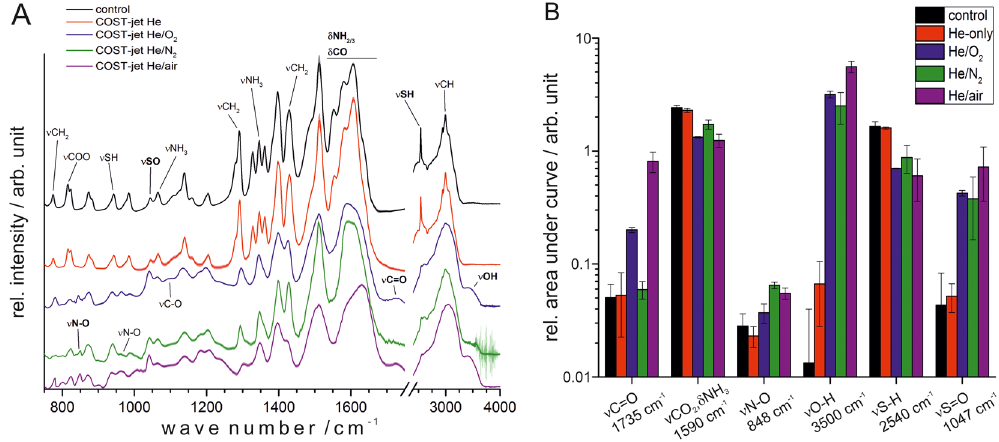
Figure 1. FTIR spectroscopy ( A ) and peak quantification ( B ) of He-based plasmas using the COST-Jet. Spectra were recorded after 10 min of treatment. Bold annotations were used for quantification. “Control” samples were treated only with He-only gas. The graphs are stacked for better